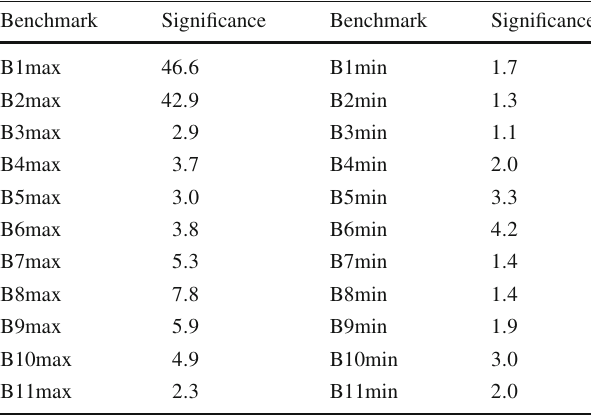
Table 7 The significance (in standard deviations) of the six b -jet anal- ysis in h 1 h 1 h 1 , applied to the benchmark points of Tables 5 and 6.